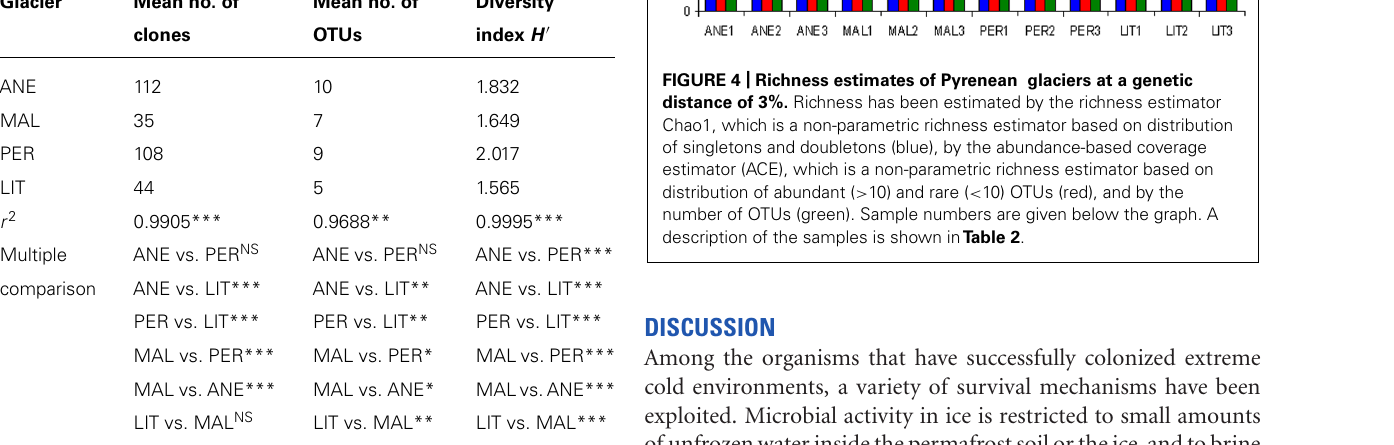
Table 4 | Number of clones, number of OTUs, and diversity index for the samples from Pyrenean glaciers. Glacier Mean no. of Mean no. of